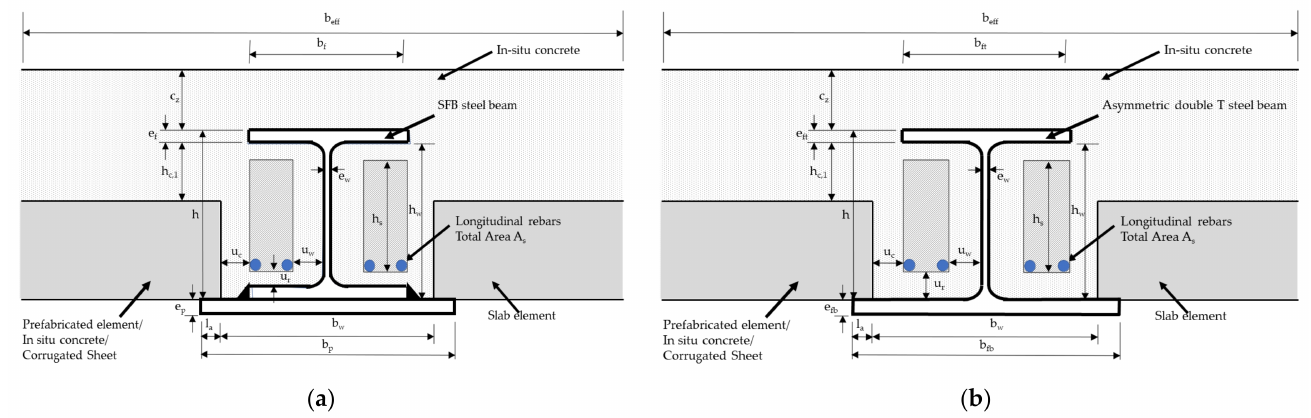
Figure 9. ( a ) SFB [21] and ( b ) asymmetric double-T cross-section with